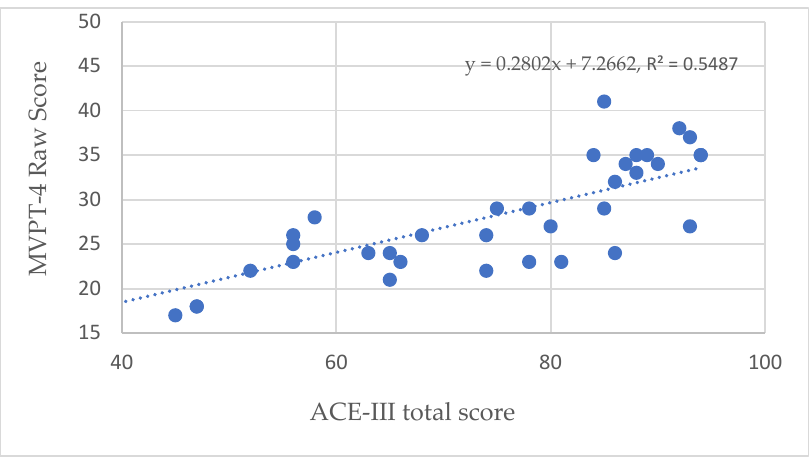
Figure 1. Validity of the ACE-III compared with MVPT-4.